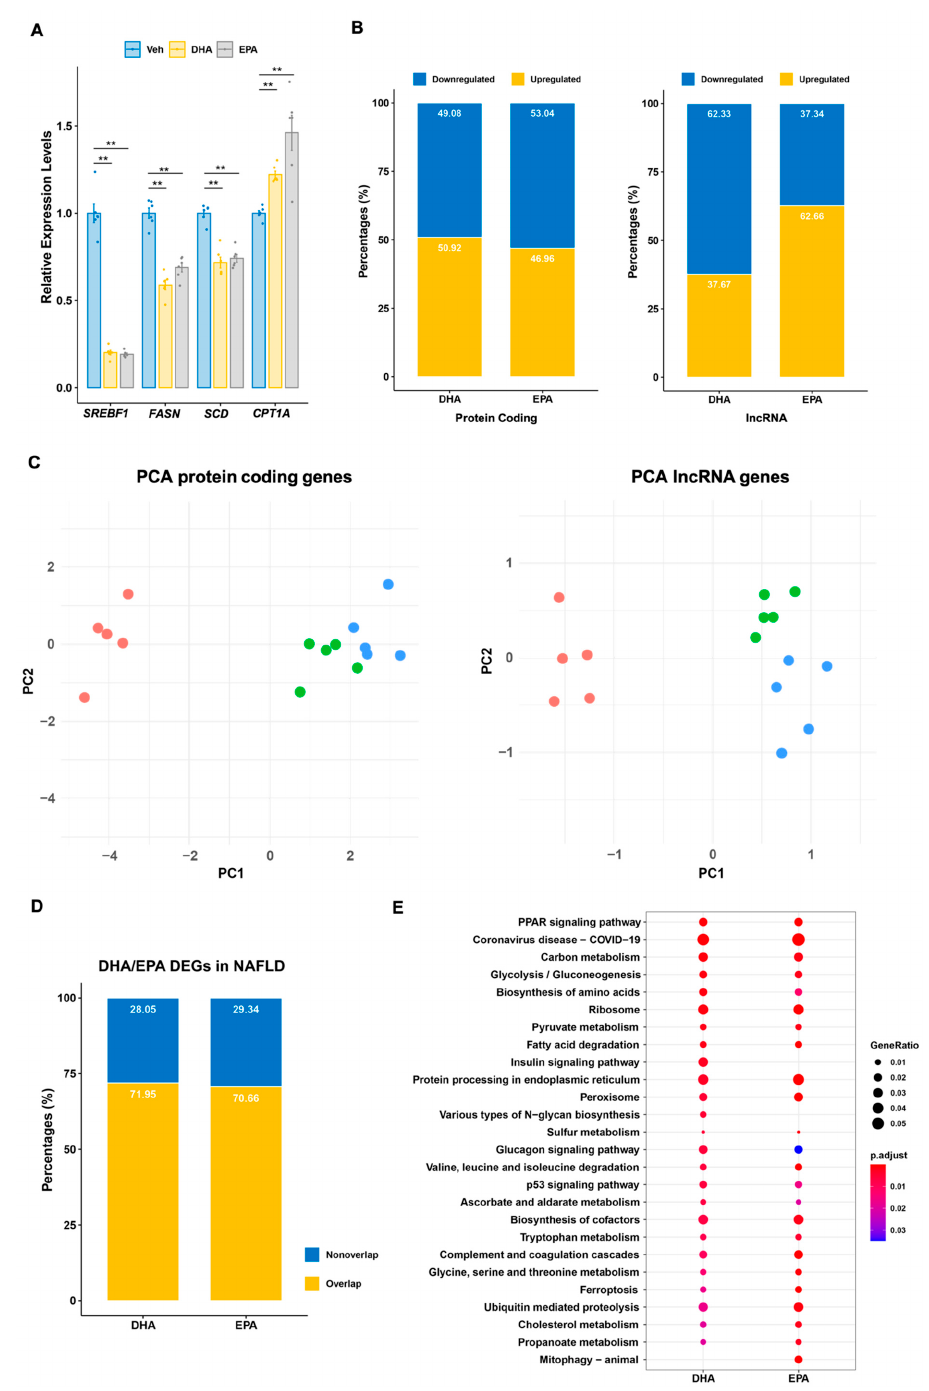
Figure 1. Nutrigenomic response to omega-3 fatty acid in human hepatocytes. ( A ) Expression of genes involved in de novo lipogenesis and fatty acid oxidation after 16h treatment with 200 µ M DHA or EPA. Number of replicates = 5, error bar represents SEM, ** p < 0.001, two-tailed unpaired Student’s t-test. ( B ) Composition of differentially expressed genes responding to DHA or EPA. Bar charts representing the percentages of protein coding (left) or lncRNA (right) DEGs up or downregulated by DHA or EPA. ( C ) PCAs of expressed protein coding (left) and lncRNA (right) genes in primary hepatocytes in response to DHA/EPA/vehicle. ( D ) Relevance of n -3 PUFA DEGs in NAFLD. Percentage of n -3 PUFA responsive genes differentially expressed in NAFLD. ( E ) GO term analyses for n -3 PUFA responsive genes differentially expressed in